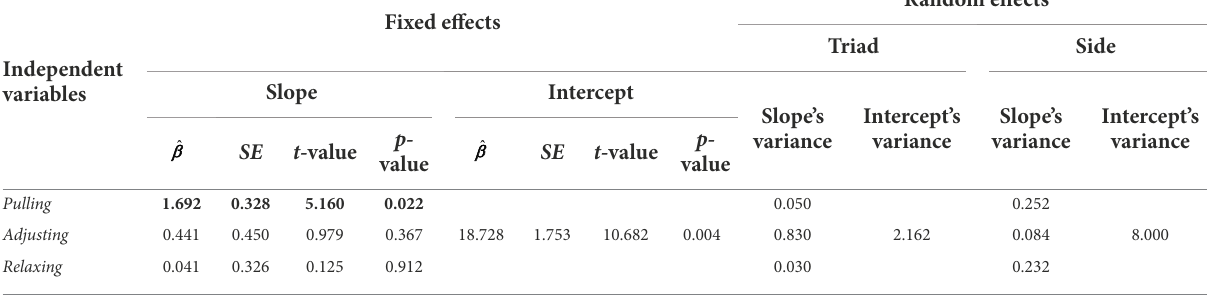
TABLE 3 Relationship between improved task performance through trials and tension peak frequencies in the pulling and adjusting, and relaxing roles considering the variabilities between triads and sides.